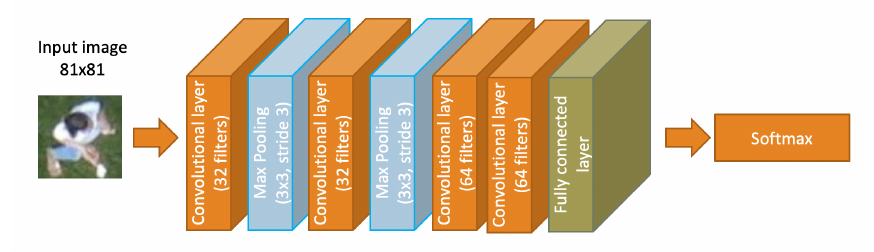
Figure 1. Classification network